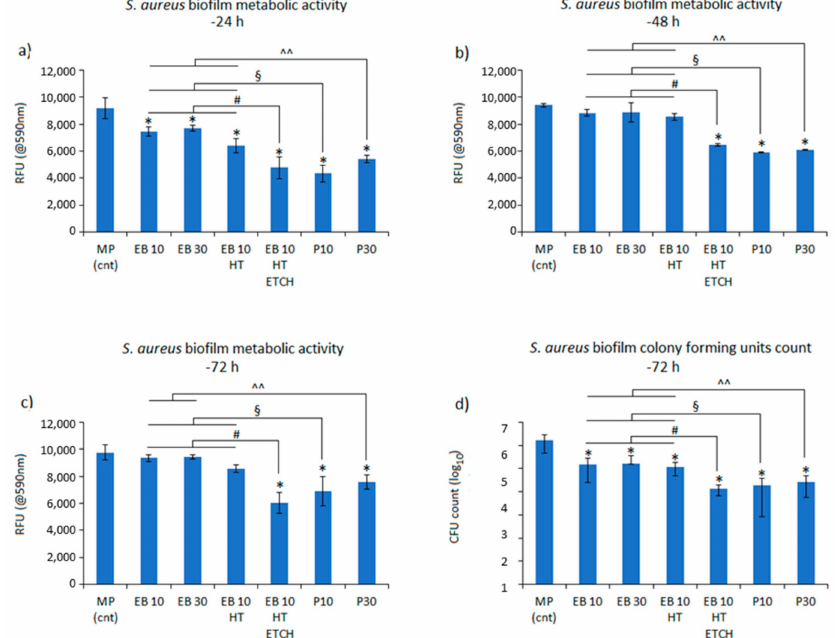
Figure 5. Bacterial metabolic activity evaluation ( a = 24 h, b = 48 h, c = 72 h) and ( d ) number count of the viable colonies after 72 h. The bars represent means and standard